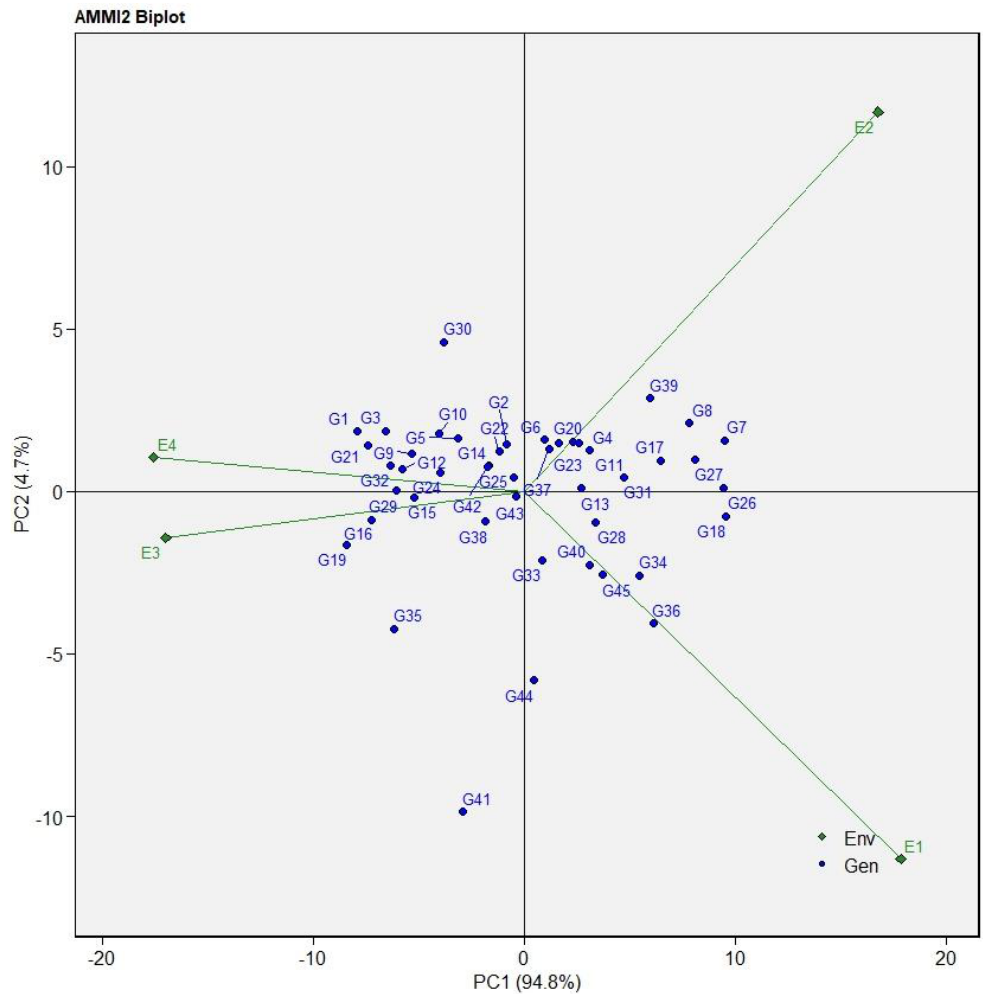
Figure 2. AMMI model biplot for IPCA1, IPCA2 scores, and seed yield in kilograms per hectare for 45 tepary bean accessions evaluated in four testing environments. E1 = LUANAR, non-stressed; E2 = LUANAR, drought-stressed; E3 = Kasinthula, non-stressed; E4 = Kasinthula, drought-stressed. Genotype codes are provided in Table 3.